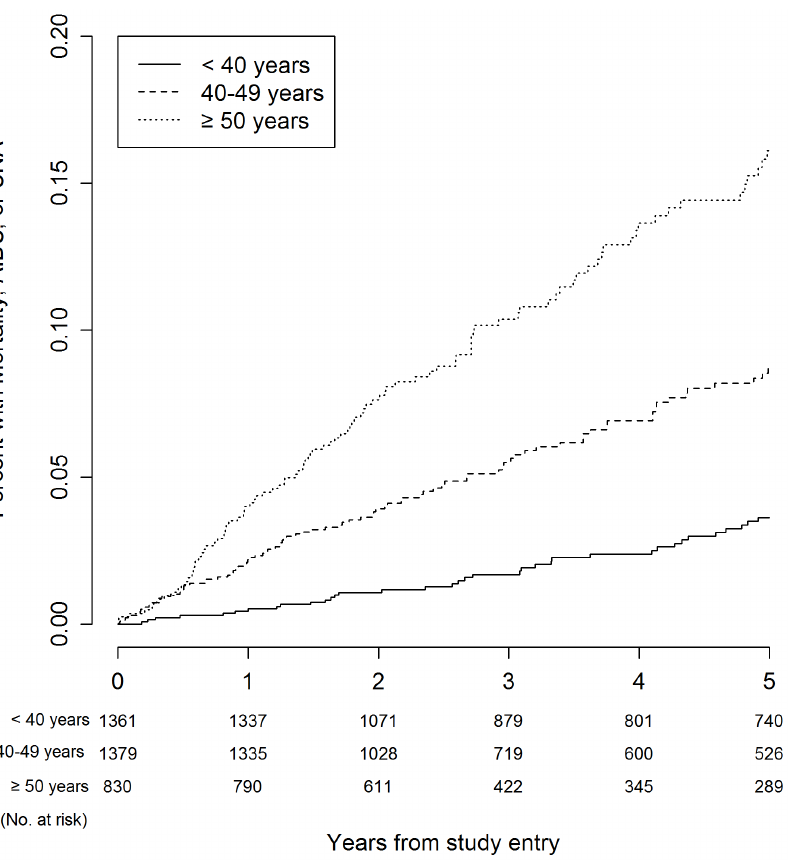
Figure 1. Cumulative probability of composite endpoint (death, SNA, or AIDS) by age group.